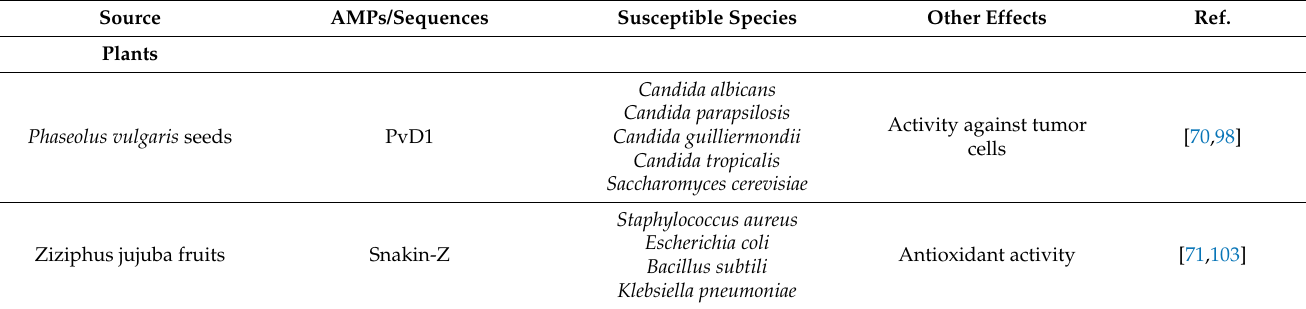
Table 1. Antimicrobial peptides extracted from sustainable sources as therapeutic options for